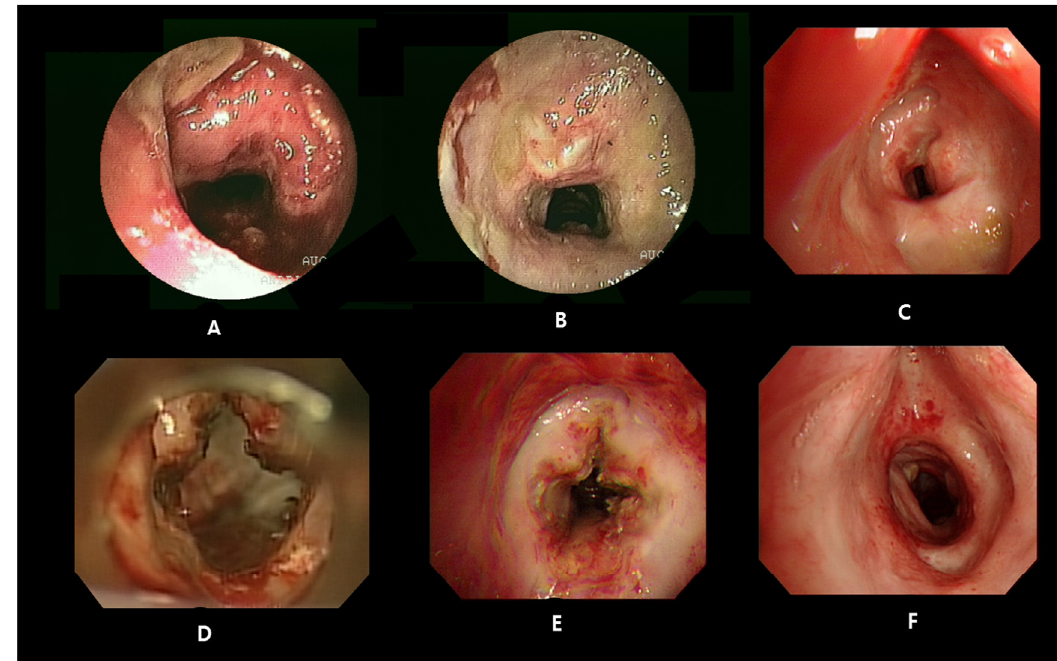
Figure 3. Initial bronchoscopy image showed severe inflammation with circumferential subglottic stenosis (SGS) ( A ). After intravenous steroid pulse therapy, SGS was improved ( B ), but restenosis was observed 5 months after discharge ( C ). Although CO 2 laser surgery for luminal widening and intralesional steroid injection were performed ( D ), SGS recurred 1 week later ( E ). The patient underwent laryngotracheal resection with remodeling; SGS was improved ( F ) and she achieved decannulation.